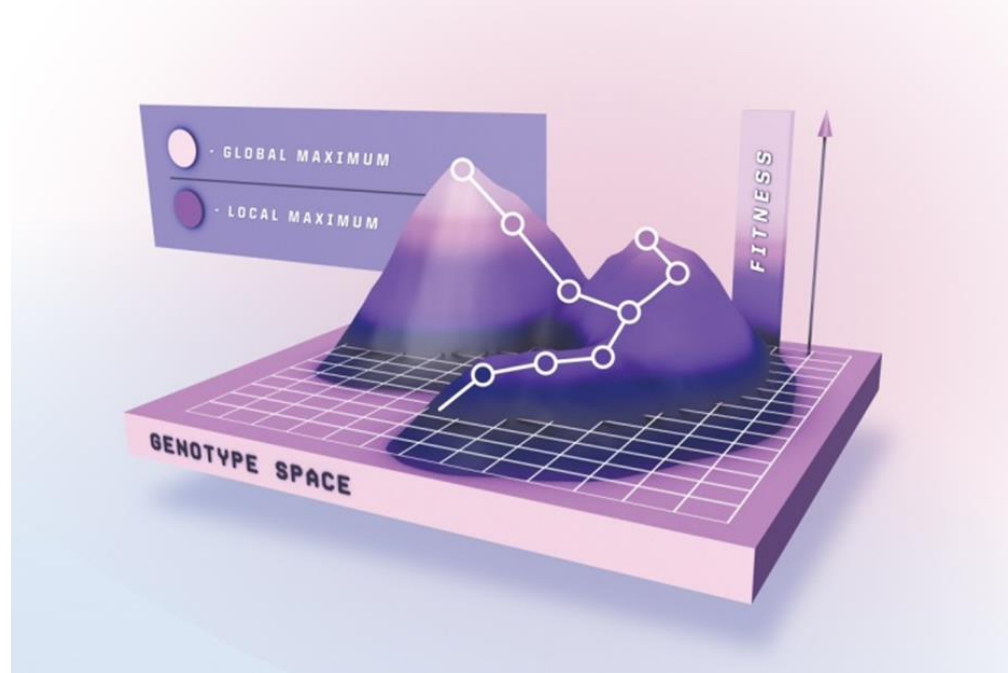
Figure 3. Maturation of a peptide depicted as ascent on a simplified fitness landscape. After each selection round, mutations are introduced into the enriched combinatorial library, and the next generation of peptides is screened for improved affinity and/or activity.